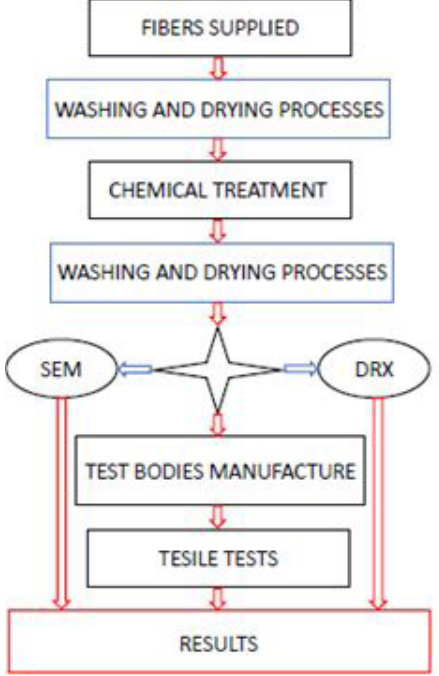
Figure 3. Schematic drawing representing the experimental procedure.